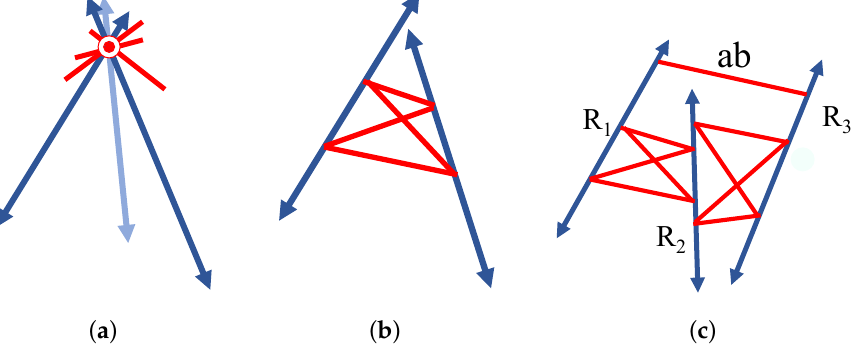
Figure 54. Two rods in space can be joined with three bars. Even formed as a clamp ( a ), this structure is flexible. With four bars ( b ) it is generically rigid: be joined in several patterns with 9 bars ( c